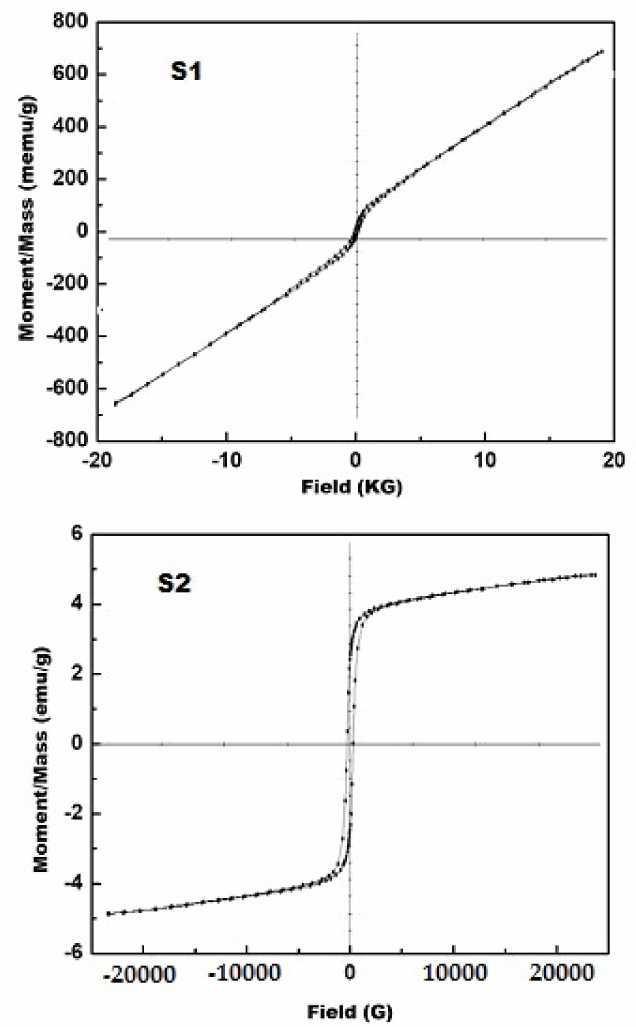
Figure 6. M-H curve of the S1 and S2 samples.